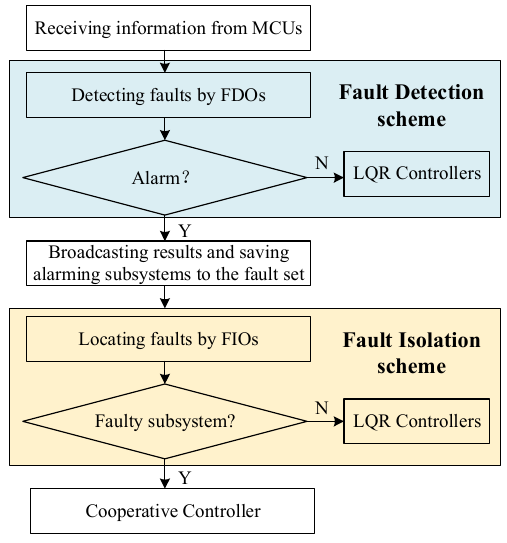
Figure 2. The function of the cloud processing unit.